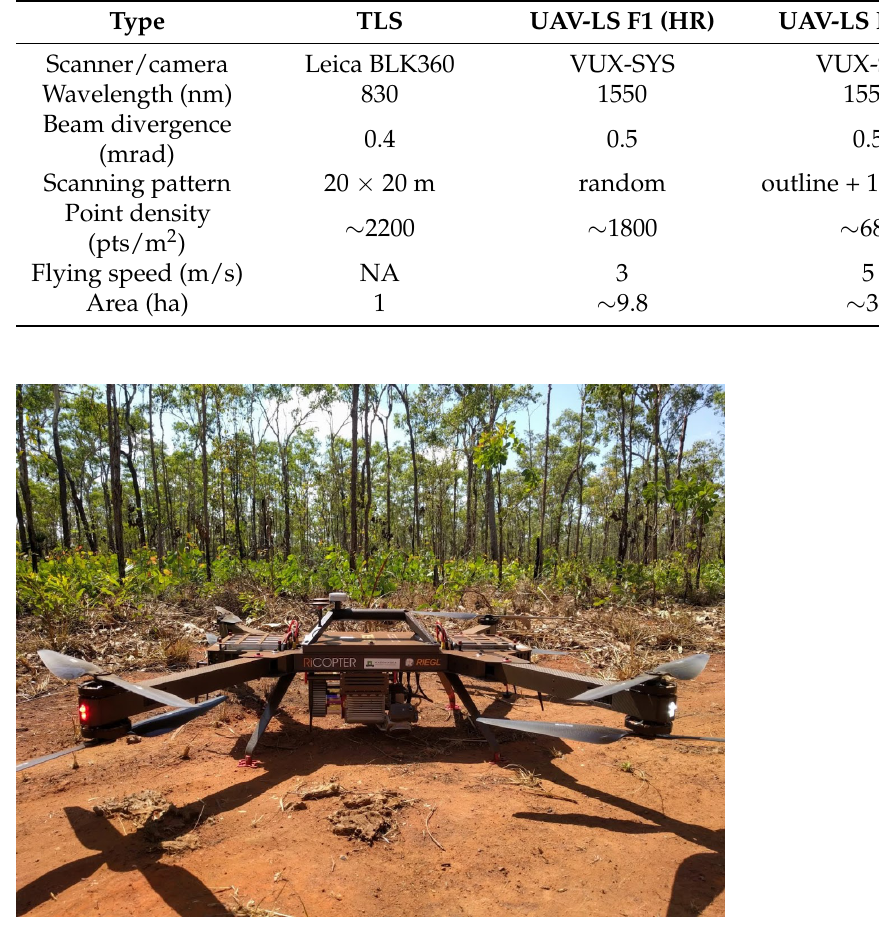
Figure 2. RIEGL RiCOPTER with